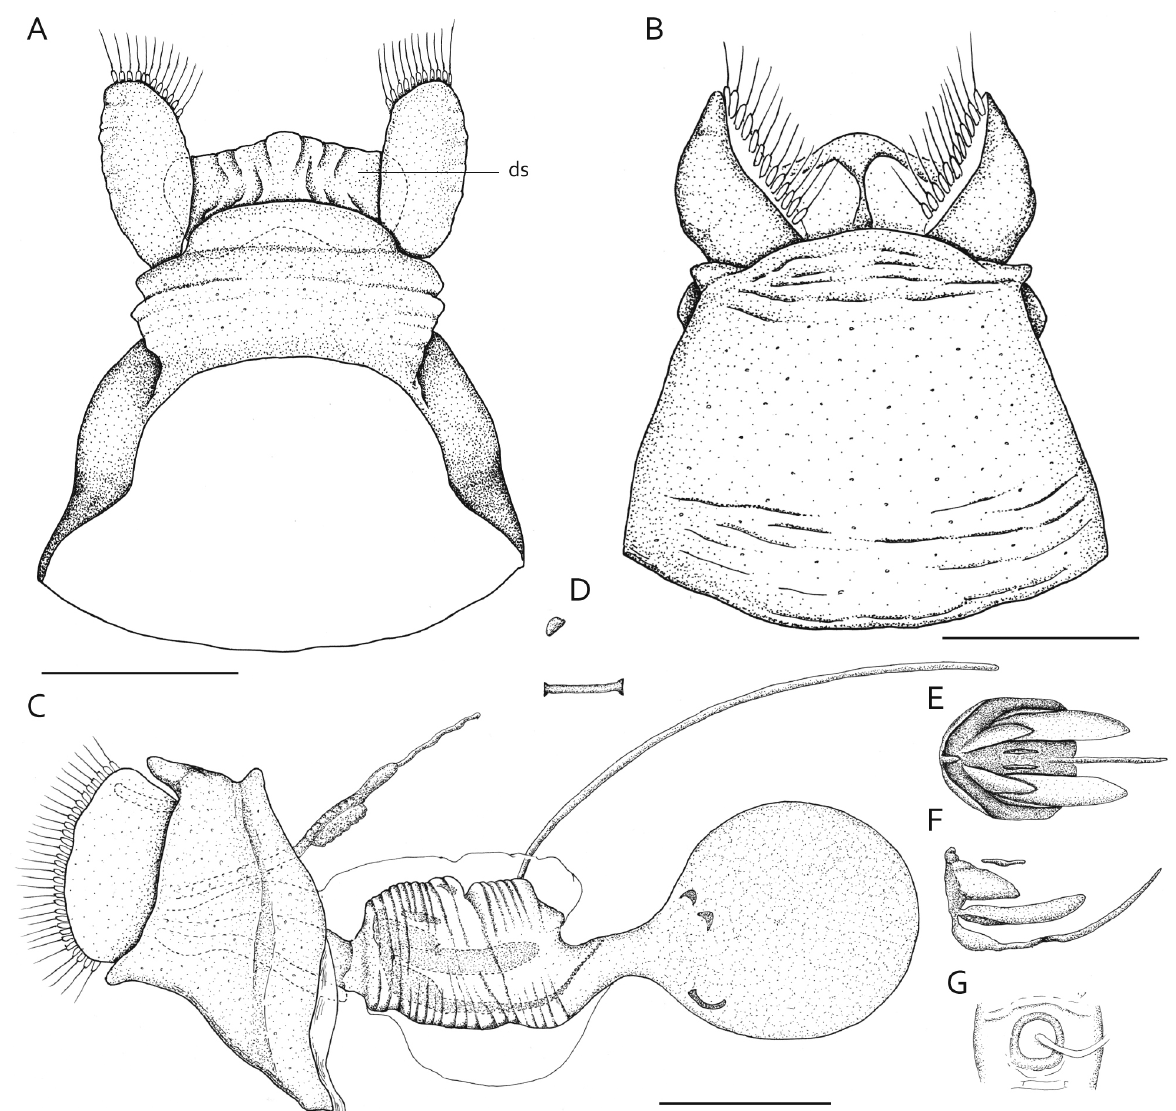
Figure 5. Female genitalia of Melinopteryx coruscans sp. n. [paratype]. A: genitalia capsule, dorsal view; B: ditto, ventral view; C: female genitalia, lateral view; D: signa; E: genital sclerite, dorsal view; F: ditto, lateral view; G: arising part of ductus sperma - thecae, dorsal view. Abbreviation: ds = dorsal sclerite. Scale bars: 0.2